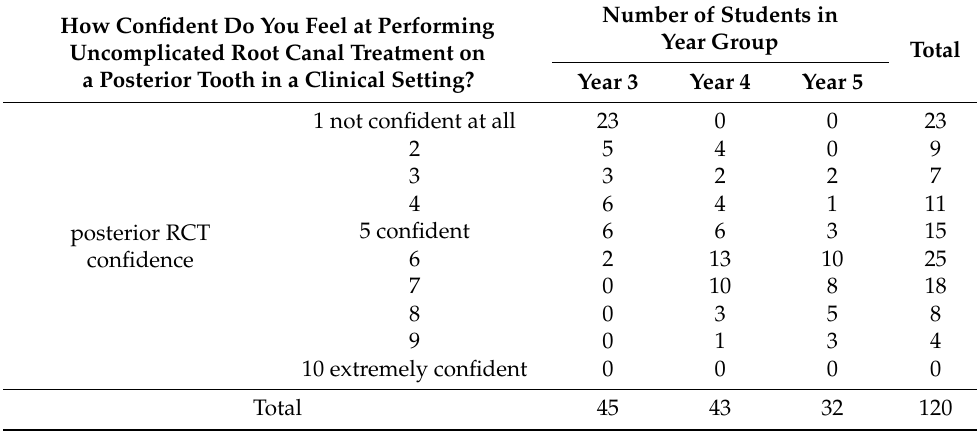
Table 2. The confidence of students in performing posterior